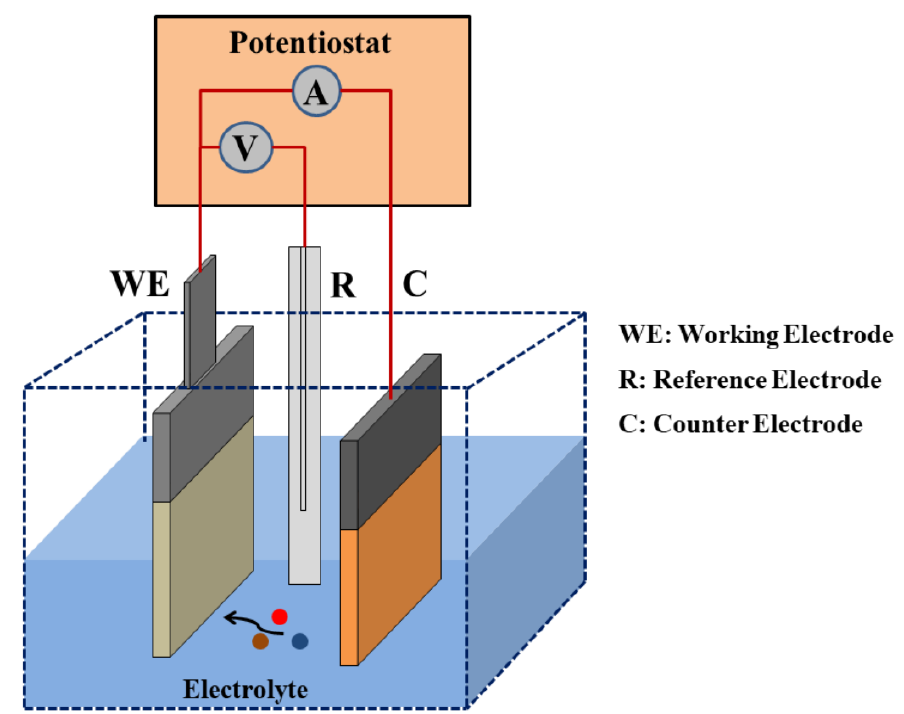
Figure 2. Schematic diagram of an electrodeposition setup [30]. Reprinted with permission from [30]; 2019 Mediterranean Journal of Chemistry.